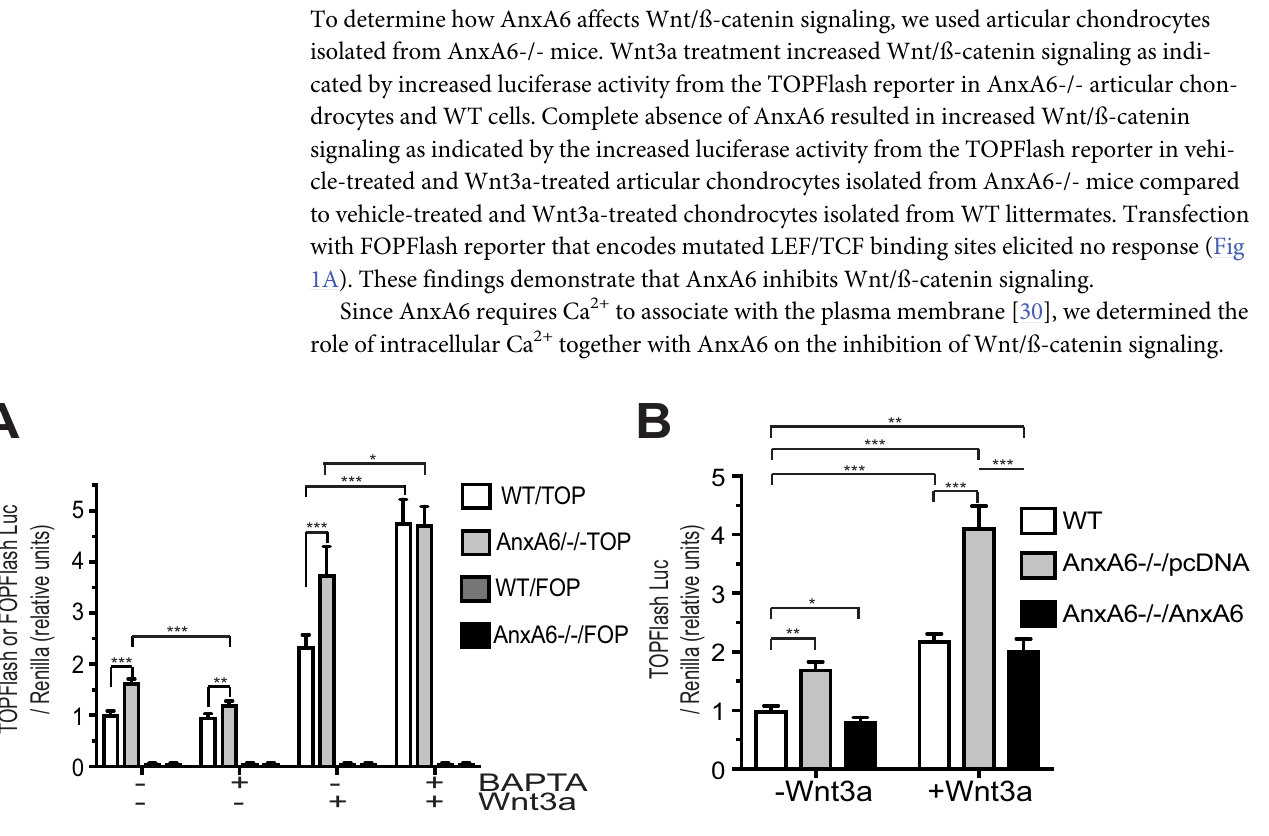
Fig 1. ß-catenin activity in mouse AnxA6-/- and WT articular chondrocytes. A: ß-catenin activity was determined by luciferase activity from the TOPFlash (TOP) or FOPFlash (FOP) luciferase reporter in vehicle-treated, Wnt3a-treated, and BAPTA-2AM/Wnt3a-treated WT and AnxA6-/- mouse articular chondrocytes. B: ß-catenin activity was determined by luciferase activity from the TOPFlash (TOP) or FOPflash (FOP) luciferase reporter in vehicle-treated, and Wnt3a-treated WT or AnxA6-/- mouse articular chondrocytes that were transfected with empty pcDNA expression vector (pcDNA) or pcDNA expression vector containing full-length AnxA6 cDNA (AnxA6). Mouse articular chondrocytes after transfection in A and B were serum starved followed by treatment with Wnt3a or the intracellular Ca 2+ chelator, BAPTA-2AM followed by Wnt3a. Cell extracts were then analyzed for luciferase activity 48 h post-transfection. Transfection efficiency was monitored by co-transfection with Renilla luciferase vector, which provides constitutive expression of the Renilla luciferase reporter. Values were normalized to Renilla luciferase activity. Data are expressed relative to the normalized luciferase activity levels from the TOPFlash reporter of vehicle-treated WT cells, which was set as 1. Data ( n = 4) are expressed as mean ± SD. ( (cid:3) p < 0.05; (cid:3)(cid:3) p < 0.01; (cid:3)(cid:3)(cid:3) p <